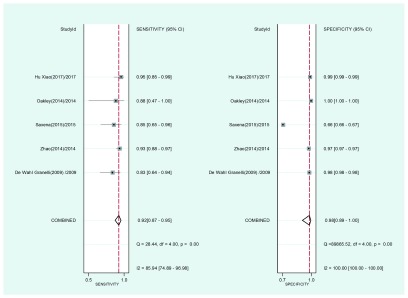
Joint “Forest plot” for sensitivity and specificity for the physical examination with oximetry as a screening test to detect critical congenital heart disease in asymptomatic newborns.